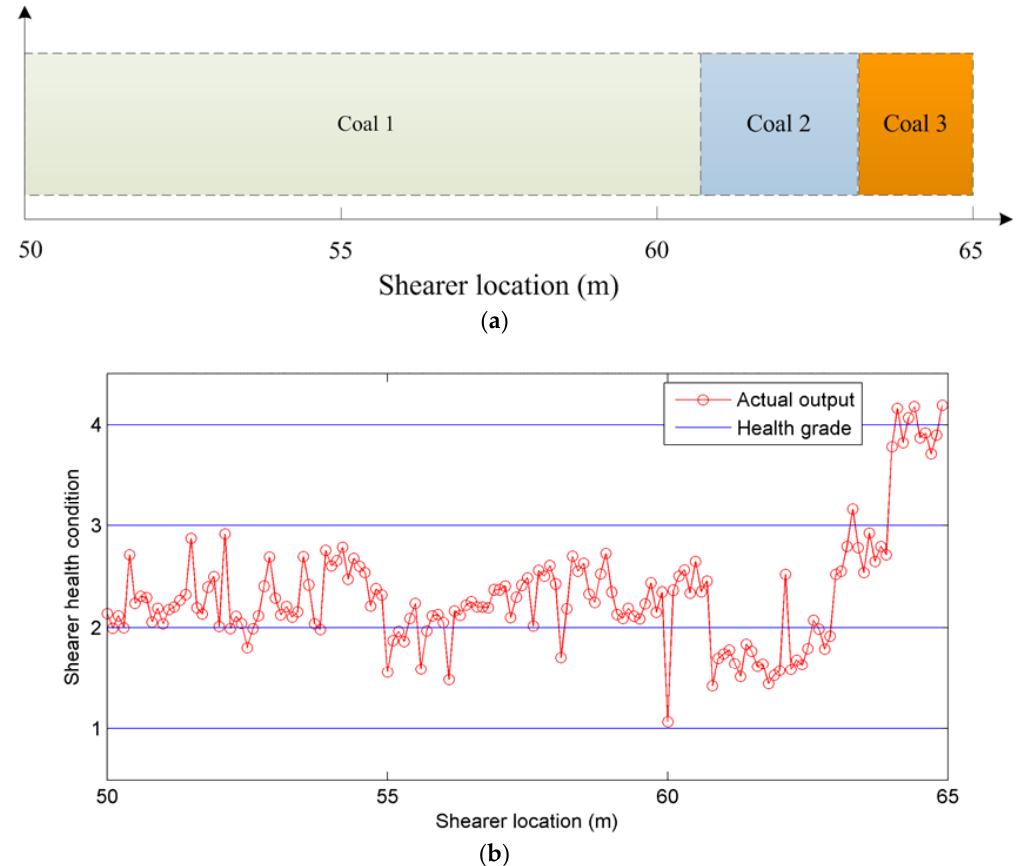
Figure 10. The evaluation results of shearer health condition based on proposed system: ( a ) the coal seam condition; and ( b ) the evaluation results.